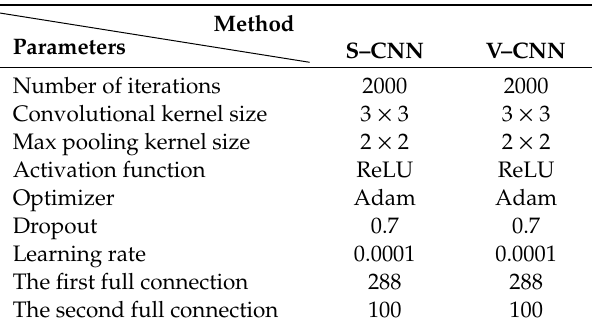
Table 6. Parameter settings of the CNNs.